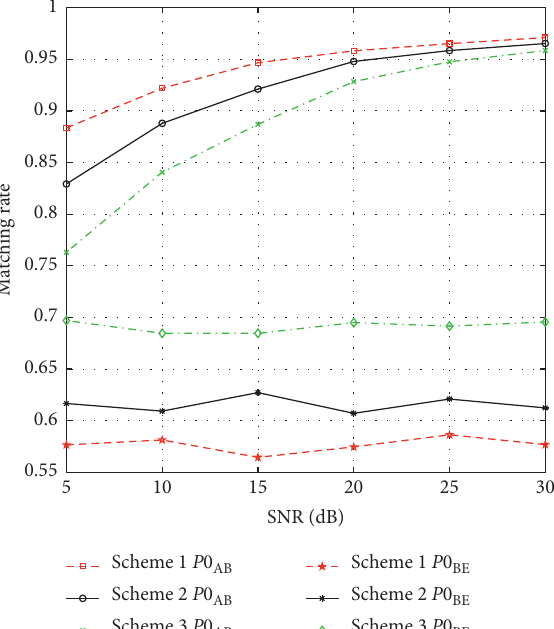
Figure 4: The matching rate of the secret key random parameters among Bob, Alice, and Eve changes with the channel